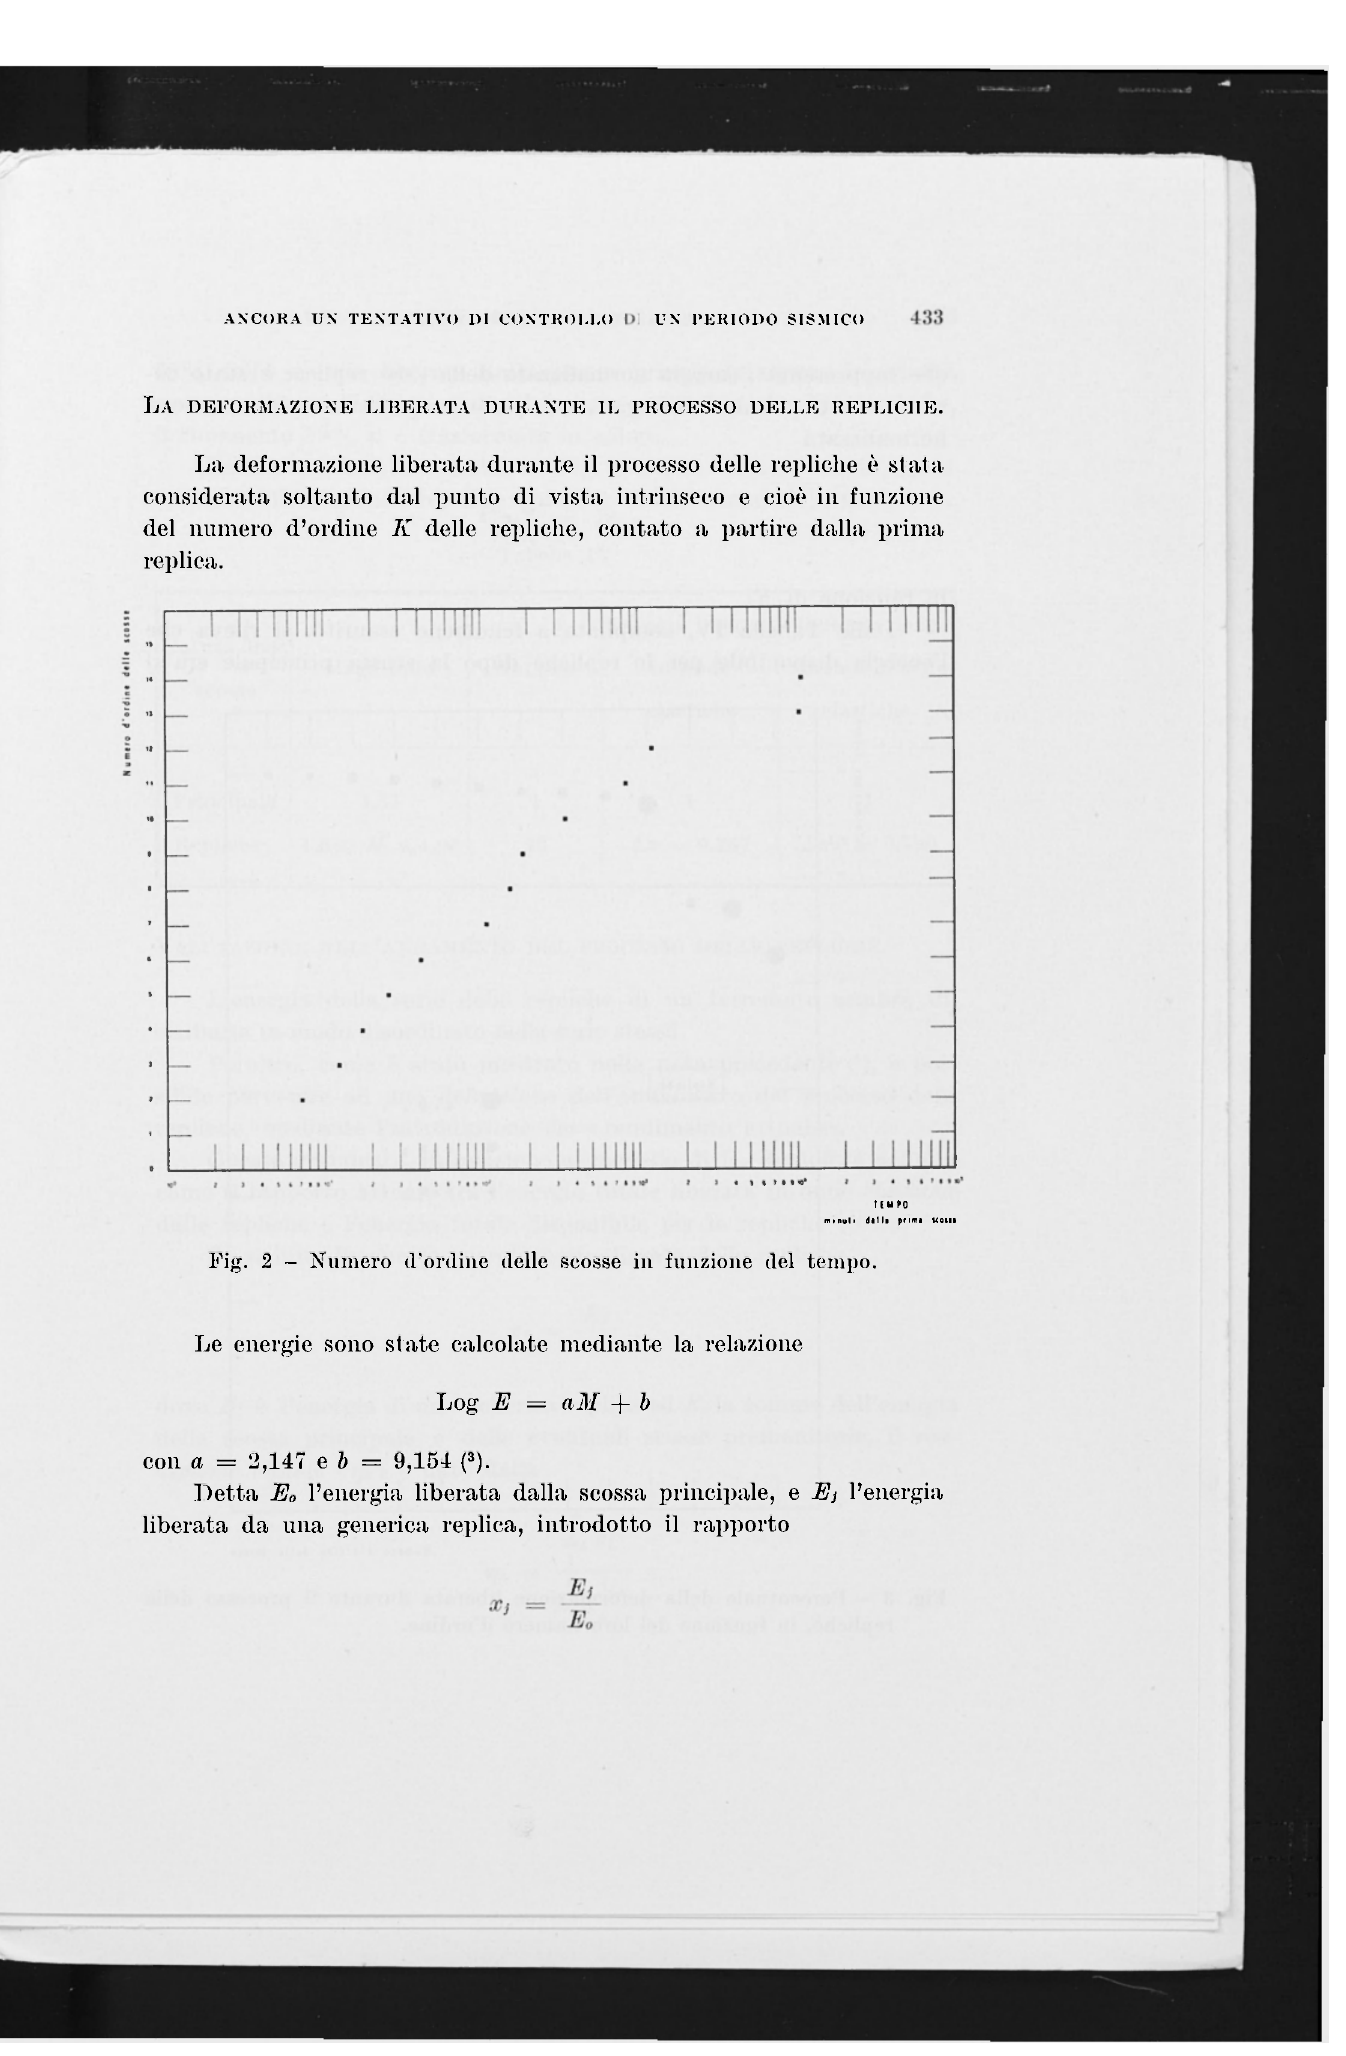
Le energie sono state calcolate mediante la relazione Log E = aM + b con a = 2,147 e b = 9,154 ( 3